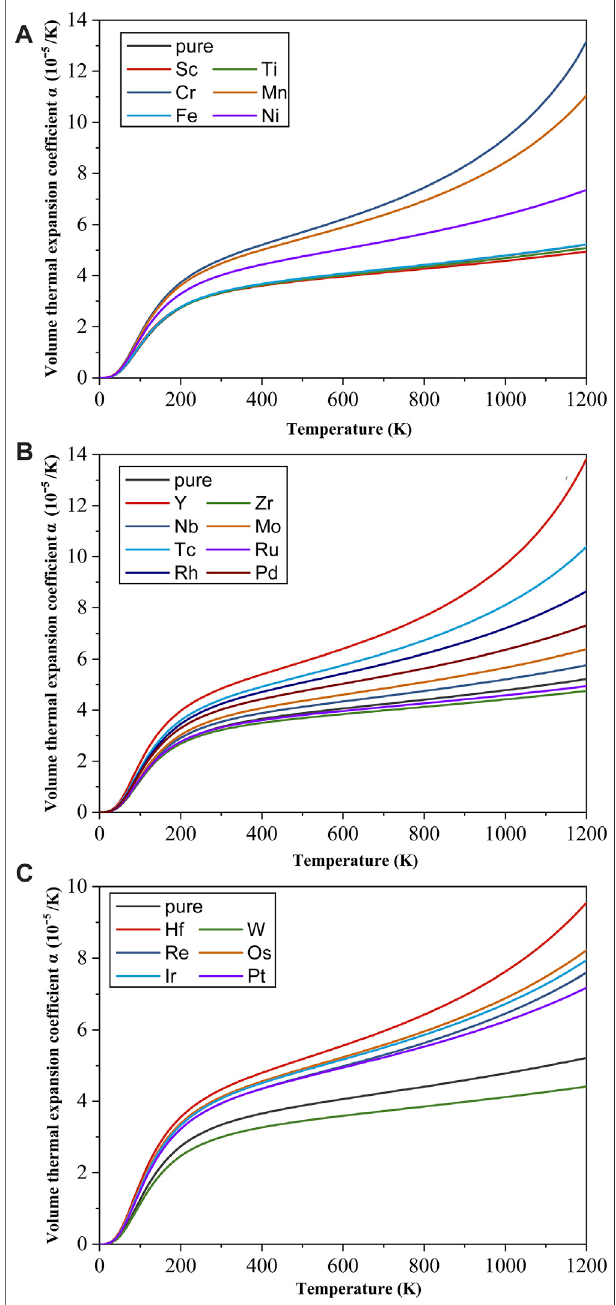
FIGURE 10 | Isobaric heat capacity C p of γ ′ -Co 3 (V, Ta) doped with (A) 3d elements, (B) 4d elements, and (C) 5d elements.